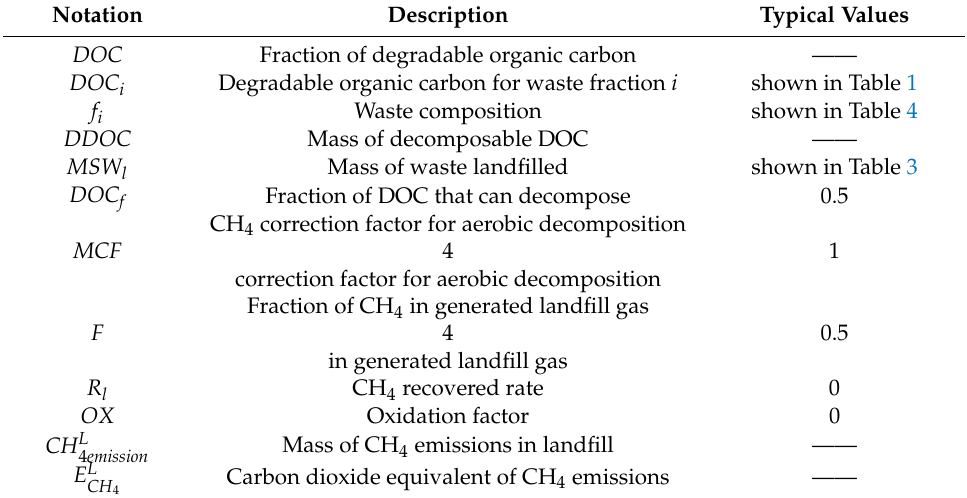
Table 7. Relevant parameters of GHG emissions calculation model for MSW